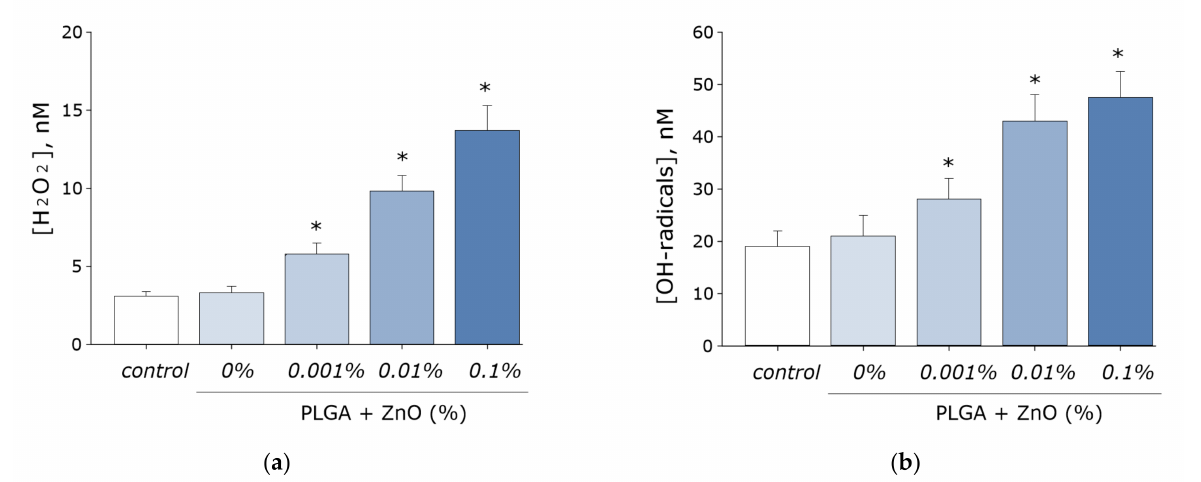
Figure 7. Effect of composite material containing PGLA and ZnO nanoparticles on the generation of reactive oxygen species: ( a ) Formation of hydrogen peroxide (2 h, 40 ◦ C); ( b ) Generation of hydroxyl radicals (2 h, 80 ◦ C); * indicate a significant difference at 5% level in comparison with the control ( p < 0.05). Data are presented as mean values and standard errors of main.